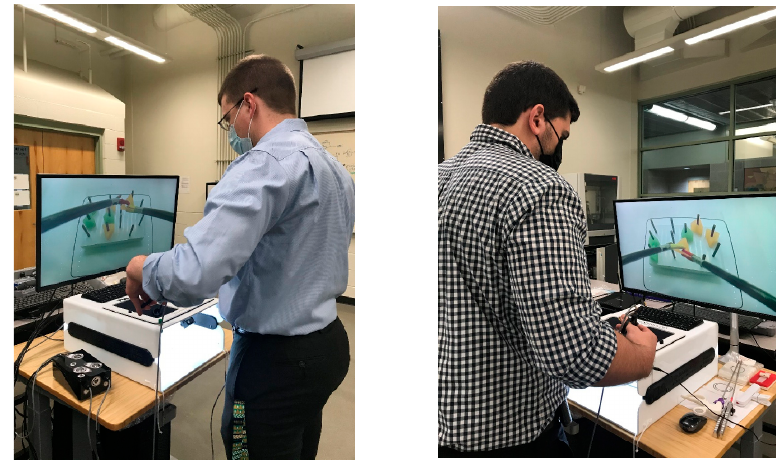
Figure 3. WMed surgical residents using the IBTS for laparoscopic training tasks.